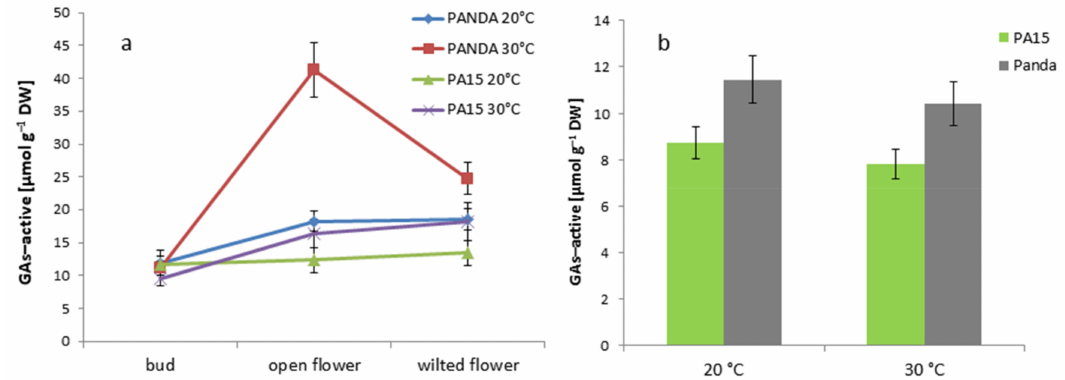
Figure 6. GAs [ µ mol g − 1 DW] in the flower buds, open flowers, and wilted flowers ( a ) and the leaves ( b ) of the ‘Panda’ and PA15 plants grown at 20 ◦ C (control) and 30 ◦ C (thermal stress). Means ( n = 3) ± SE. The GA level in the leaves of cv. ‘Panda’ was higher at both temperatures than in the PA15 leaves, but thermal stress did not affect the GA amounts in either genotype (Figure 6b).